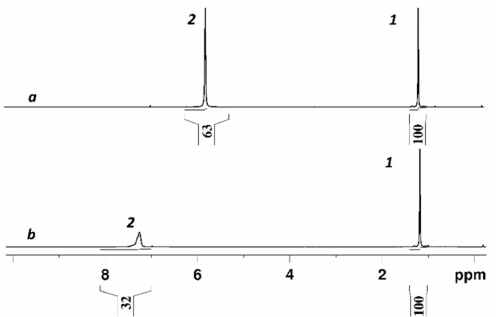
Figure 6. The example of 1 H NMR spectra of Nafion 117 membrane in 95 volume percent CCl 4 + 5 volume percent of C 6 H 12 : ( a ) Nafion 117 membrane equilibrated at 75% RH , ( b ) Nafion 117 membrane equilibrated at 10% RH ; 1–signal of C 6 H 12 , 2–signal of water and hydrated H + protons. Figures under signals are the area of NMR lines. Reprinted with permission from [25]. Copyright 2019 Springer